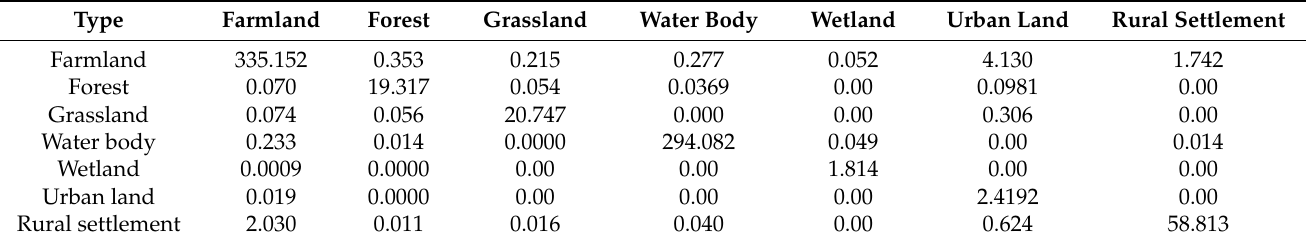
Table 6. Land use transfer matrix under NTU scenario (km 2 ).